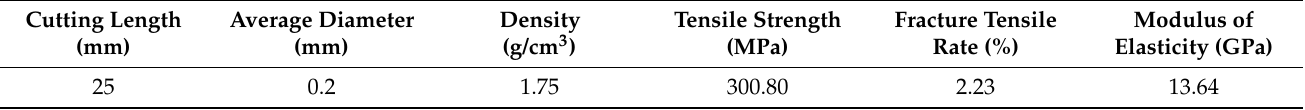
Table 1. Basic physical properties of sisal fiber.